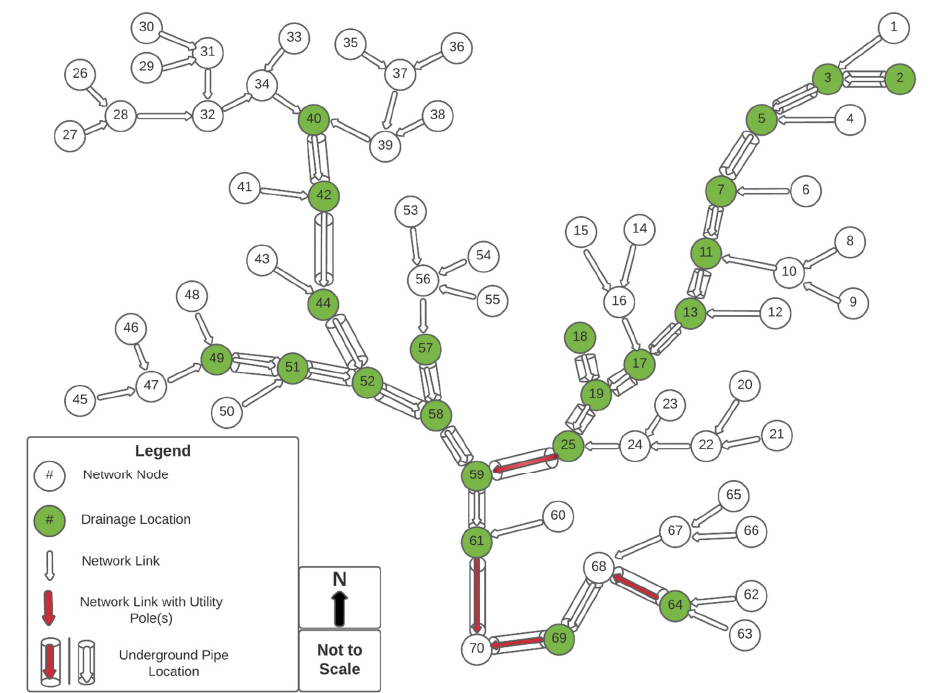
Figure 7. Leadville. CO watershed network schematic for the 100 ‐ year storm.